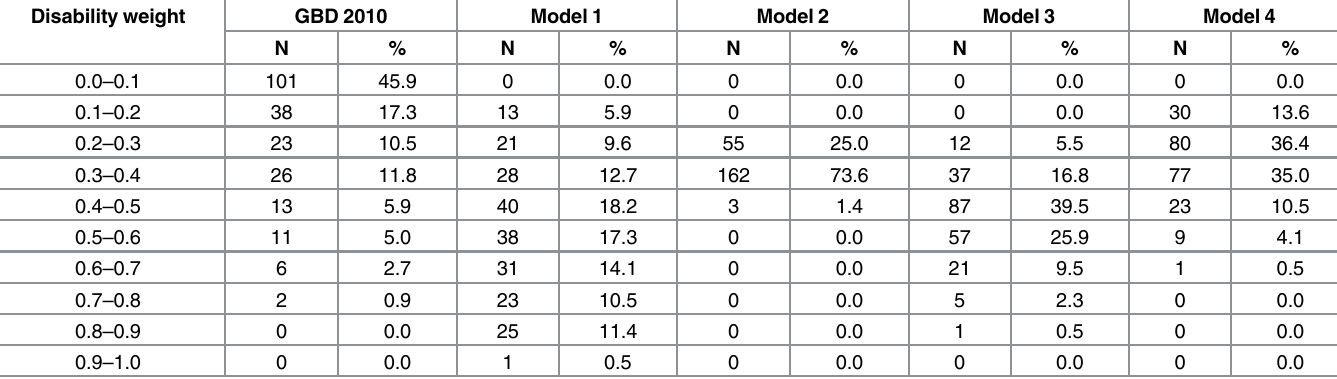
Table 3. Distribution of disability weights for the 220 health states from the GBD 2010 study according to each model. Disability